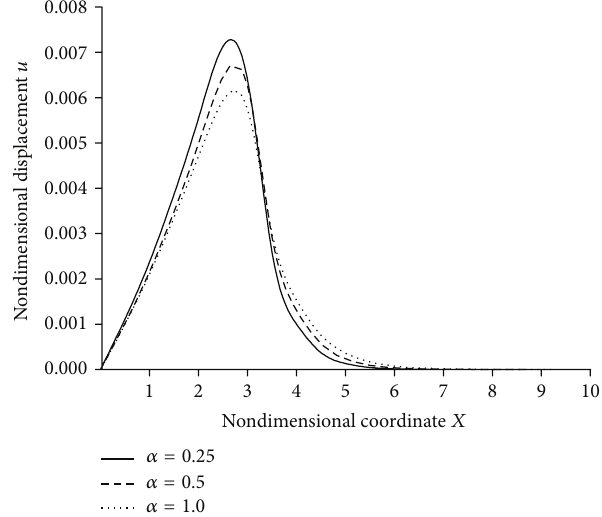
Figure 15: Nondimensional displacement distribution for different 𝛼